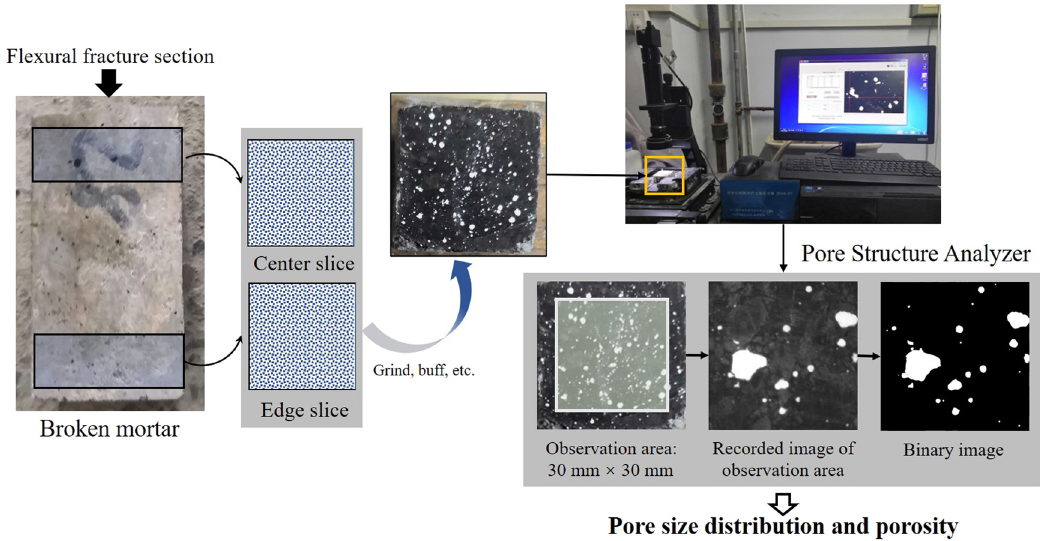
Figure 2: Pore structure